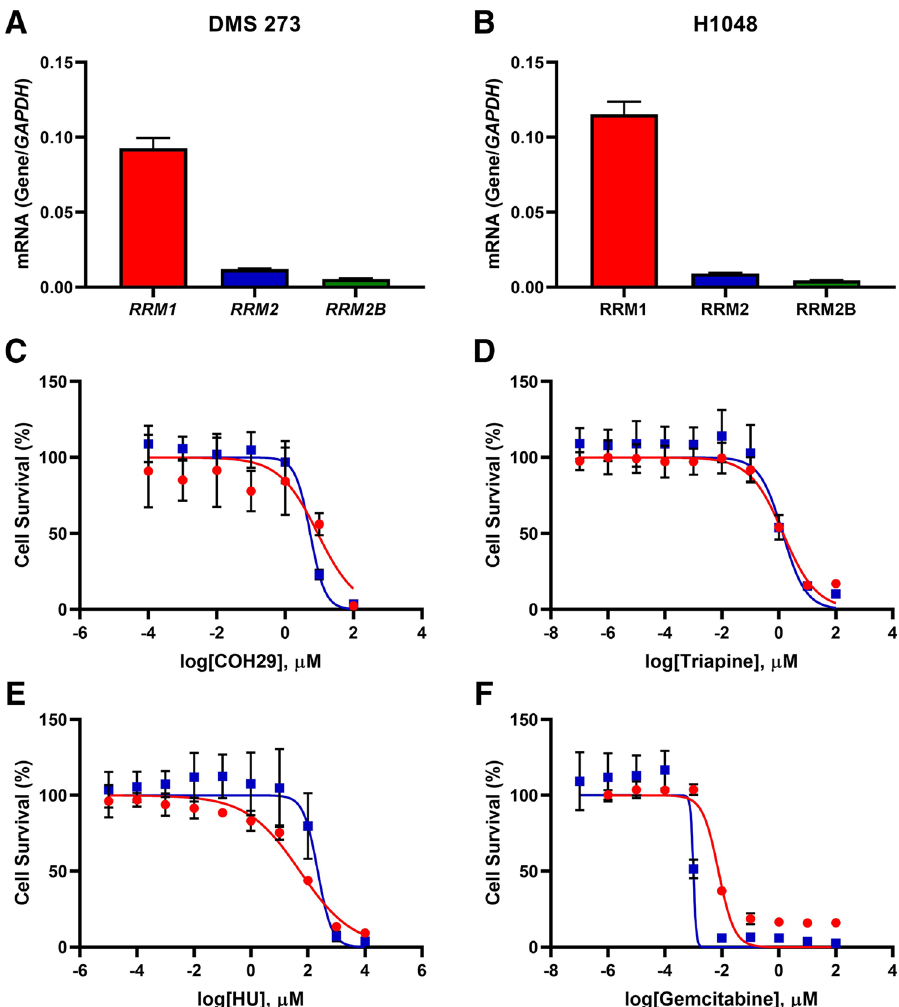
Figure 1. RRM1 expression and sensitivity to RRM1 inhibitors. A and B , mRNA expression of RNR-related genes in DMS 273 ( A ) and NCI-H1048 ( B ) cells. RRM1 (red) , RRM2 (blue), and RRM2B (green) levels were normalized to glyceraldehyde 3 ‐ phosphate dehydrogenase ( GAPDH ) expression. Data represent the mean ± standard deviation (SD; n = 3). ( C – F ), WST-8 assay with the RRM1 inhibitors COH29 ( C ), triapine ( D ), hydroxyurea ( E ), and gemcitabine ( F ). Cells were treated with the indicated inhibitors for 3 days and their viability was assessed using the WST-8 assay. Red circle: DMS 273, blue square: H1048. Data represent the mean ± SD ( n =